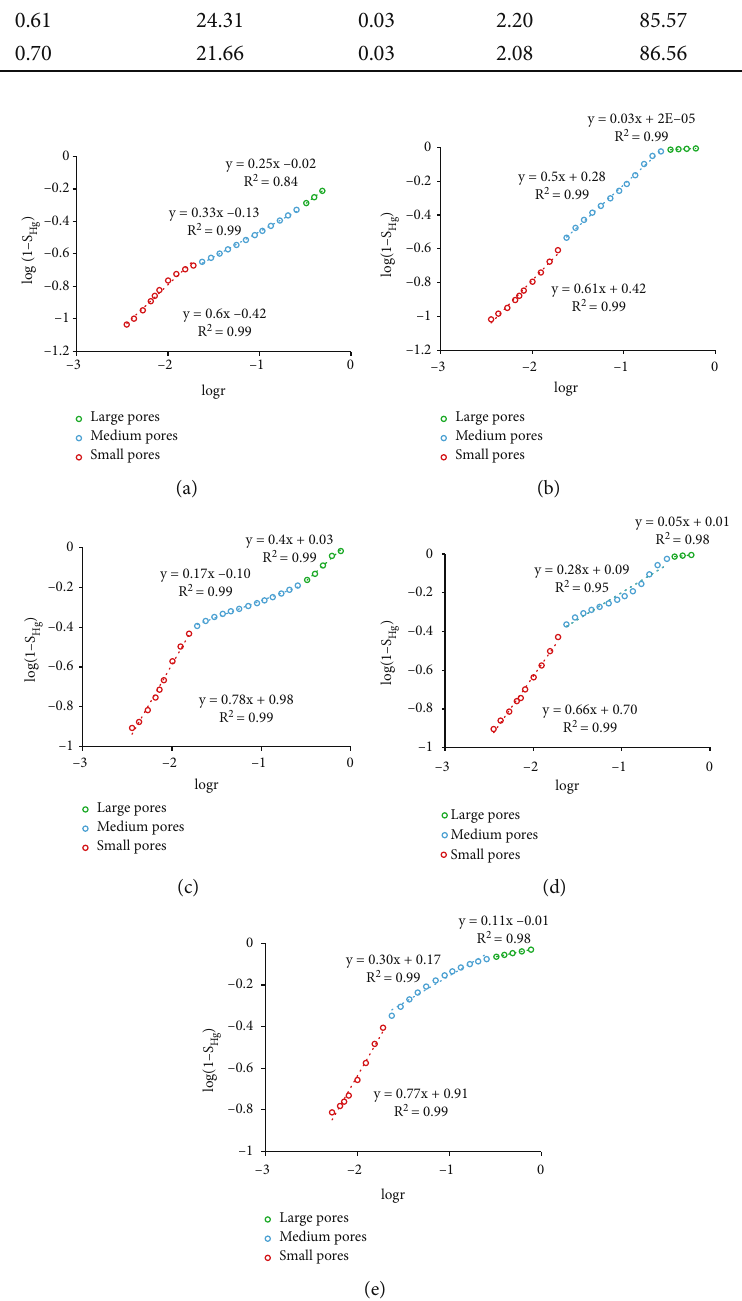
Þ and log ð r Þ of pores corresponding to samples A1-5 (a-e), Hg